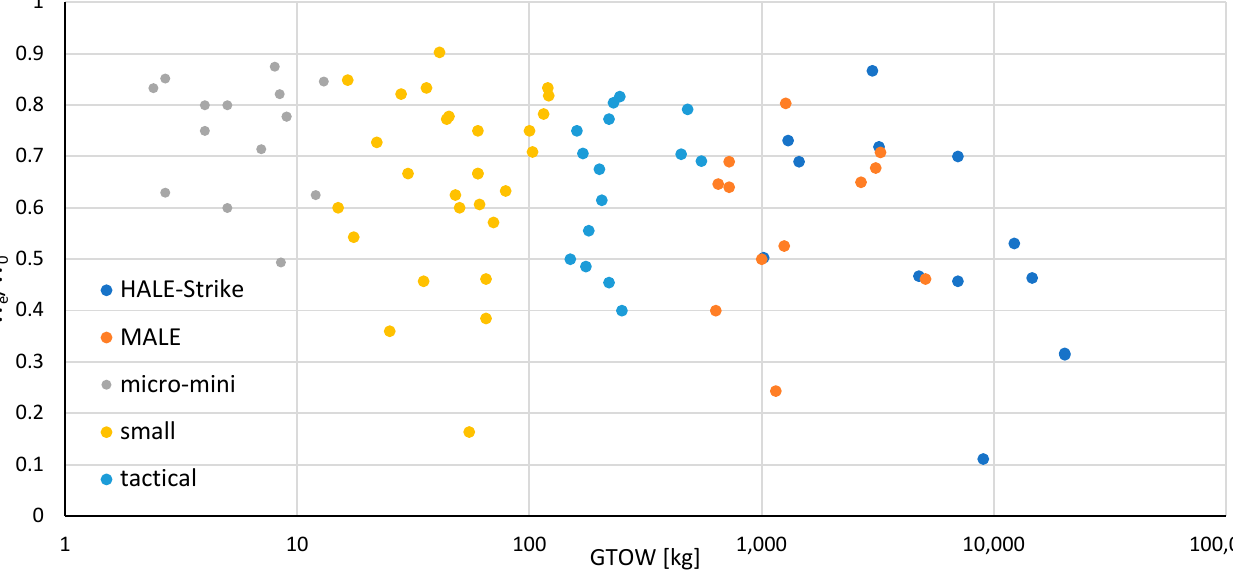
Figure 15. Empty weight divided by GTOW as a function of GTOW with respect to NATO classi fi cation.